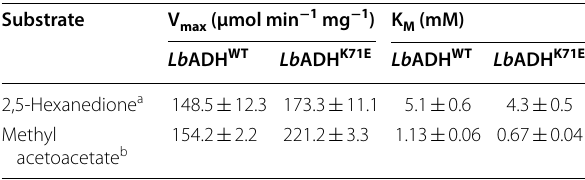
K71E exchange resulted in a change of the pI from 5.44 for Lb Adh WT to 5.17 for Lb Adh K71E . SDS-PAGE also sug-